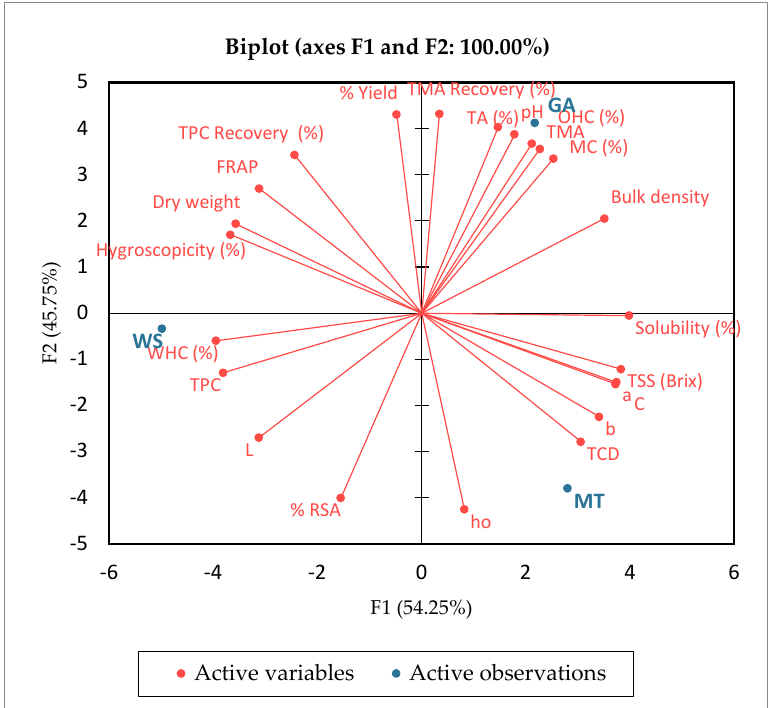
Figure 7. Principal component analysis showing the relationship between carrier agents (GA, MT, and WS) and the freeze-dried raspberry juice powder quality attributes. MC—moisture content;